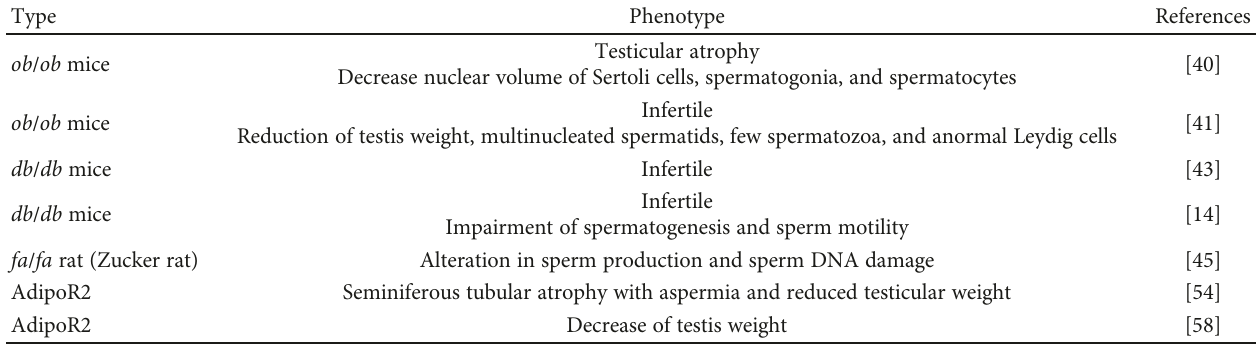
Table 1: Consequences on male fertility phenotypes of animal models with missing adipokine or adipokine